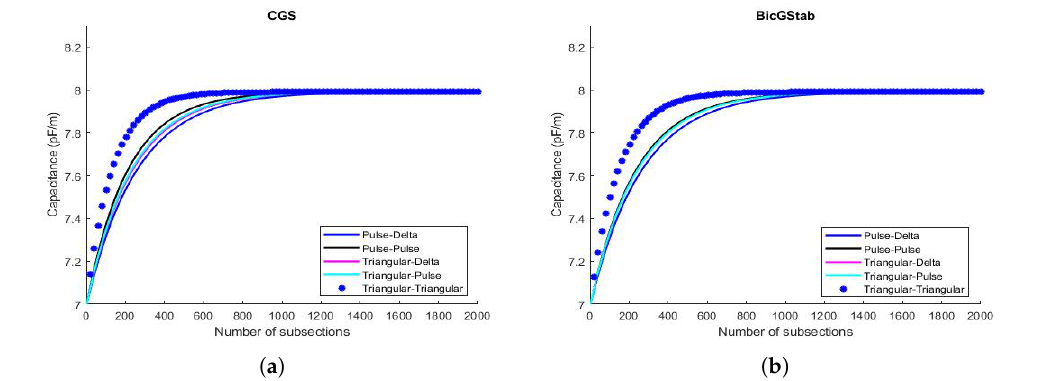
Figure 5. C vs. N when L / d ratio is equal to 400 for each basis and testing functions: ( a ) CGS and ( b ) BicGStab algorithms.